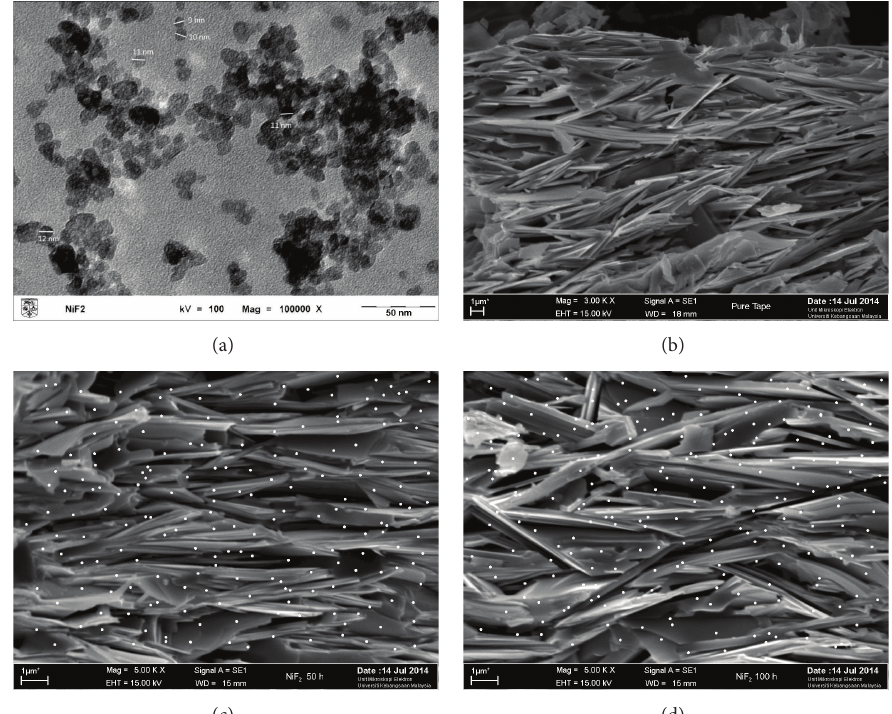
Figure 3: Micrographs of (a) NiF 2 with average size 10 nm, (b) nonadded Bi-2223 tape, (c) NiF 2 added Bi-2223 tape sintered for 50 h, and (d) NiF 2 added Bi-2223 tape sintered for 100h. White dots denote the distribution of NiF 2 nanoparticle in the tapes.